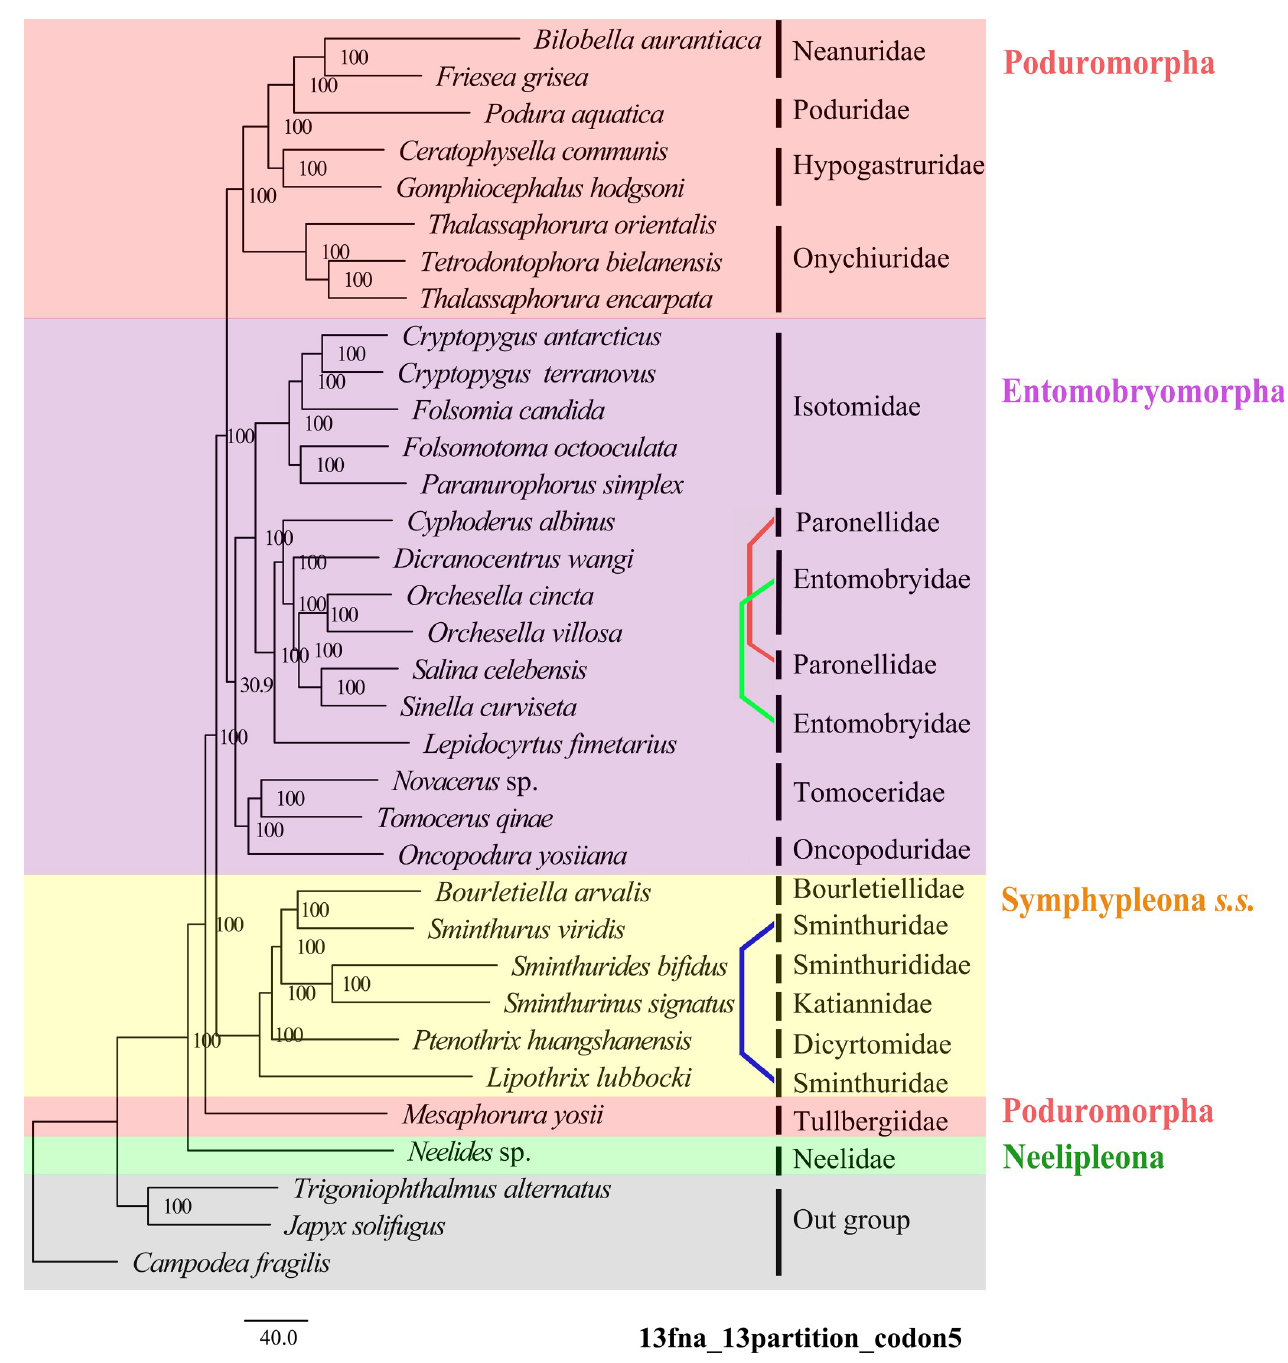
Fig 3. Maximum likelihood phylogenetic tree inferred from partitioned nucleotide sequences of 13 PCGs under codon 5 model (13fna_13parition_CODON5). Bootstrap support values are shown in the nodes. Each coloured line linked a same taxon in current taxonomic system but separated in different